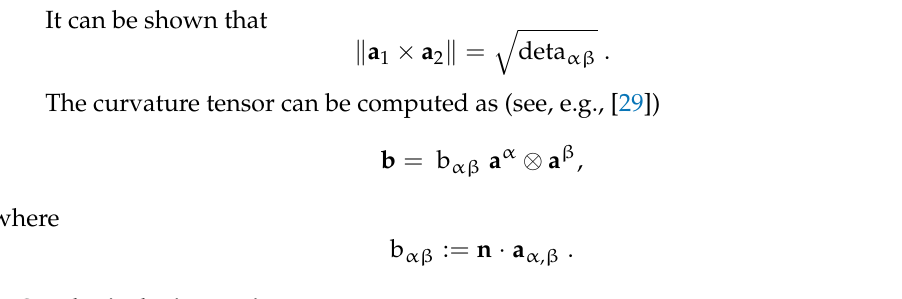
Figure 1. Mapping between parameter domain P, reference configuration S 0, and current configuration S.